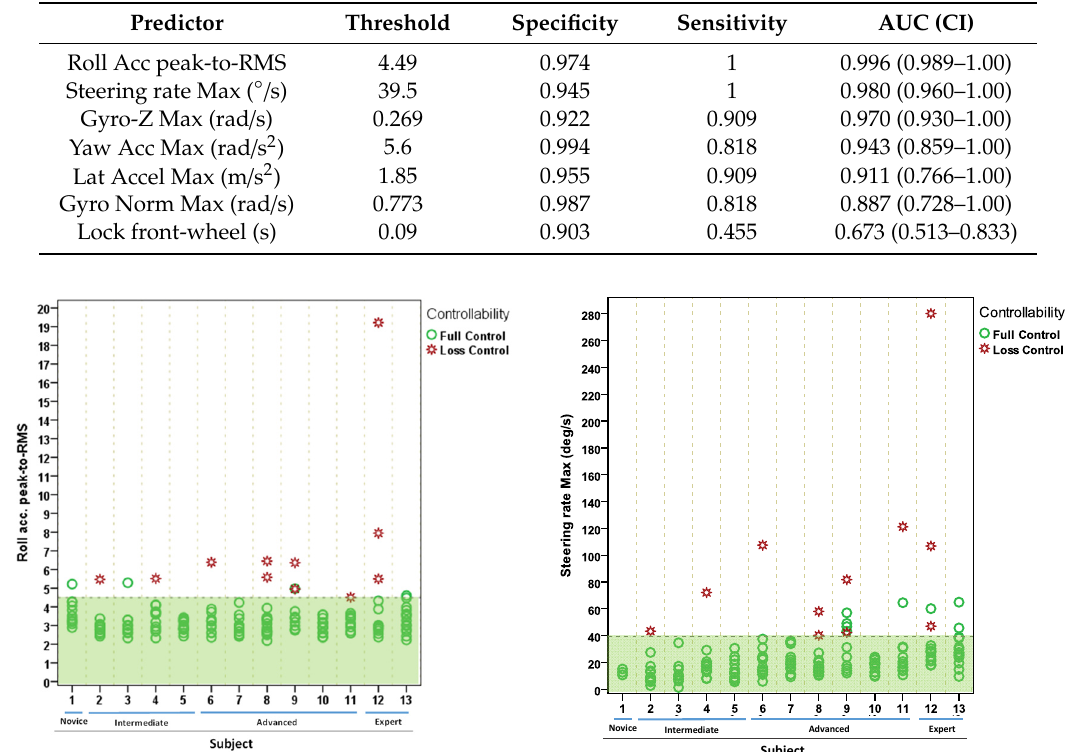
Figure 10. Scatter plot of loss of control probability by subject for the 165 braking trials for peak-to- RMS ratio of roll acceleration and “steering rate” (best decision threshold in dotted line).